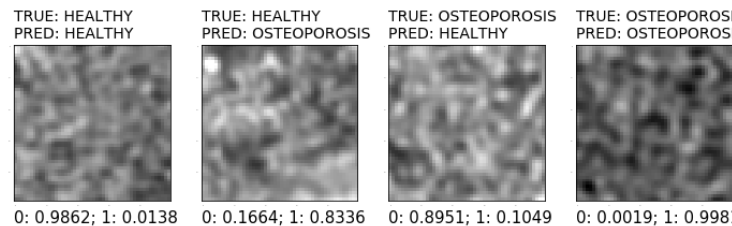
Figure 15. Process flow during the prediction of a class of new images.